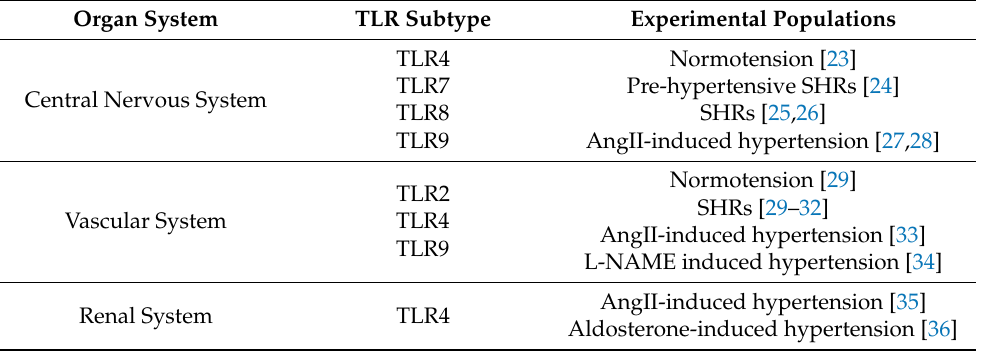
TLR4 Normotension [23] TLR7 Pre-hypertensive SHRs [24] TLR8 SHRs [25,26] TLR9 AngII-induced hypertension [27,28] Normotension [29] TLR2 SHRs [29–32] TLR4 AngII-induced hypertension [33] TLR9 L-NAME induced hypertension [34] AngII-induced hypertension [35] Aldosterone-induced hypertension